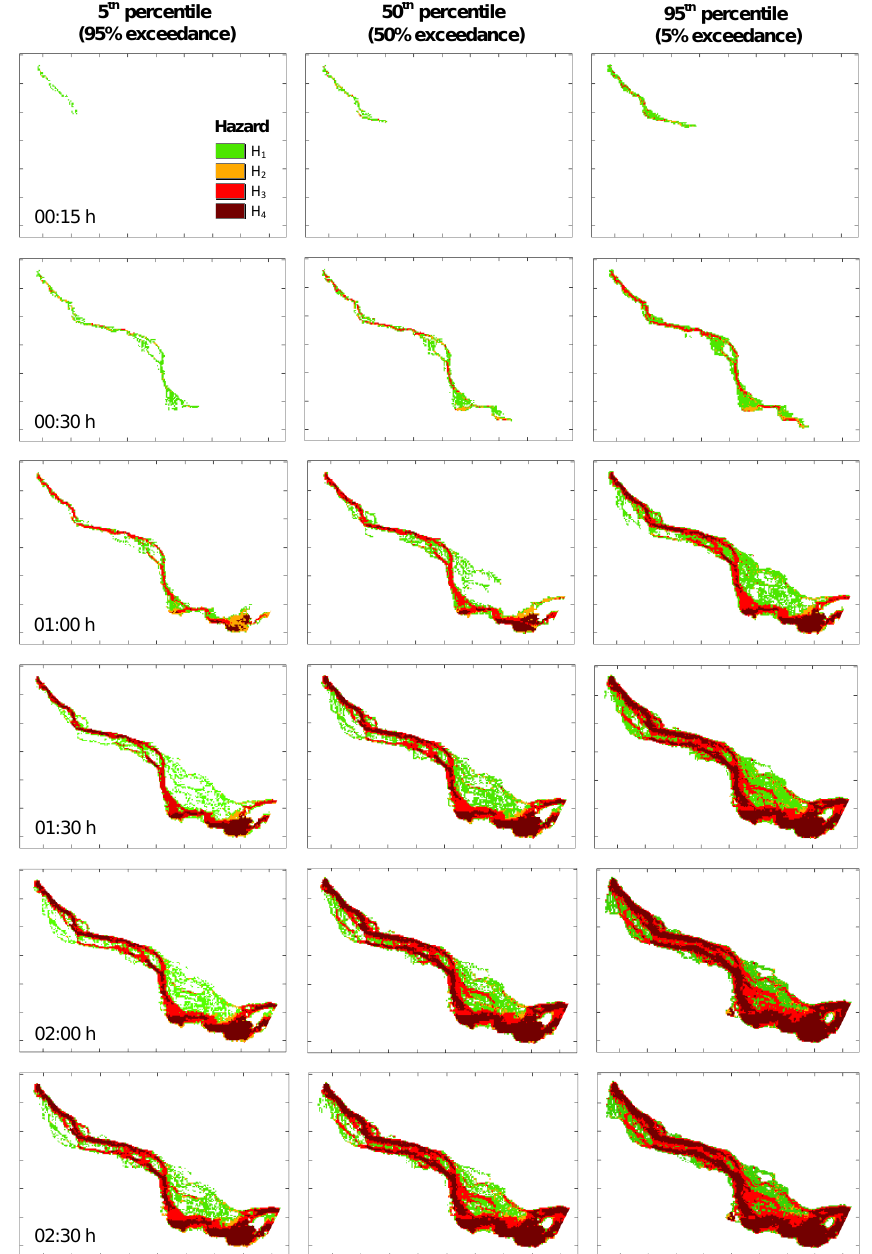
Figure 14. Percentile flood-hazard maps, based on a global hazard index forwarded by Aronica et al. (2012). Such data facilitate a prob- abilistic evaluation of the evolution of GLOF flood hazard. See Fig. 1a (this paper) for location, and Fig. 1b in Aronica et al. (2012) for description of the hazard